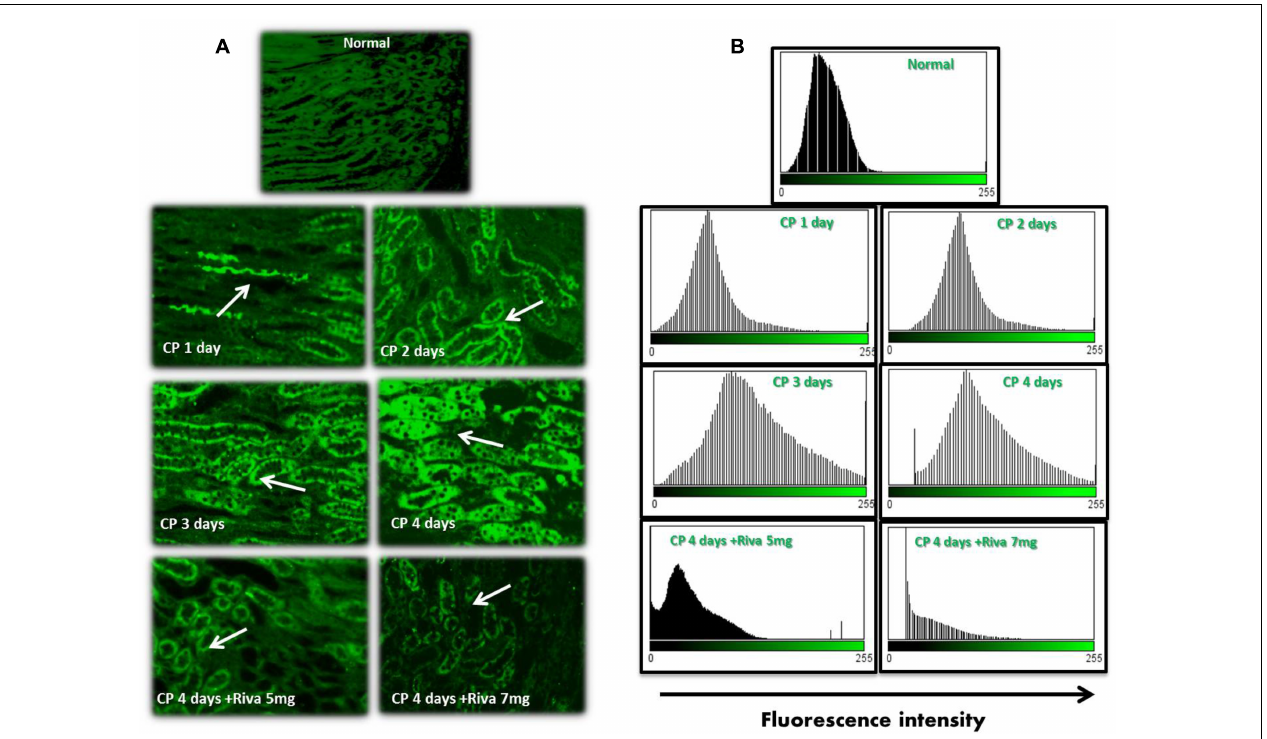
FIGURE 3 | Effect of cisplatin (CP) with or without rivaroxaban (Riva) on tissue factor (TF) expression: (A) Immunofluorescence staining of renal tubular cells in normal rats and cisplatin (6 mg/kg) treated rats after 1, 2, 3 and 4 days in absence or presence of rivaroxaban. Gradual increase in TF expression in renal tubular cells staring from 1 day till 4 days which showed the highest expression of TF protein (white arrow). A significant low expression of TF in the renal tubular cells of cisplatin pretreated with rivaroxaban. (B) Histogram showing the fluorescence cells of normal group and rats treated with cisplatin in absence or presence of